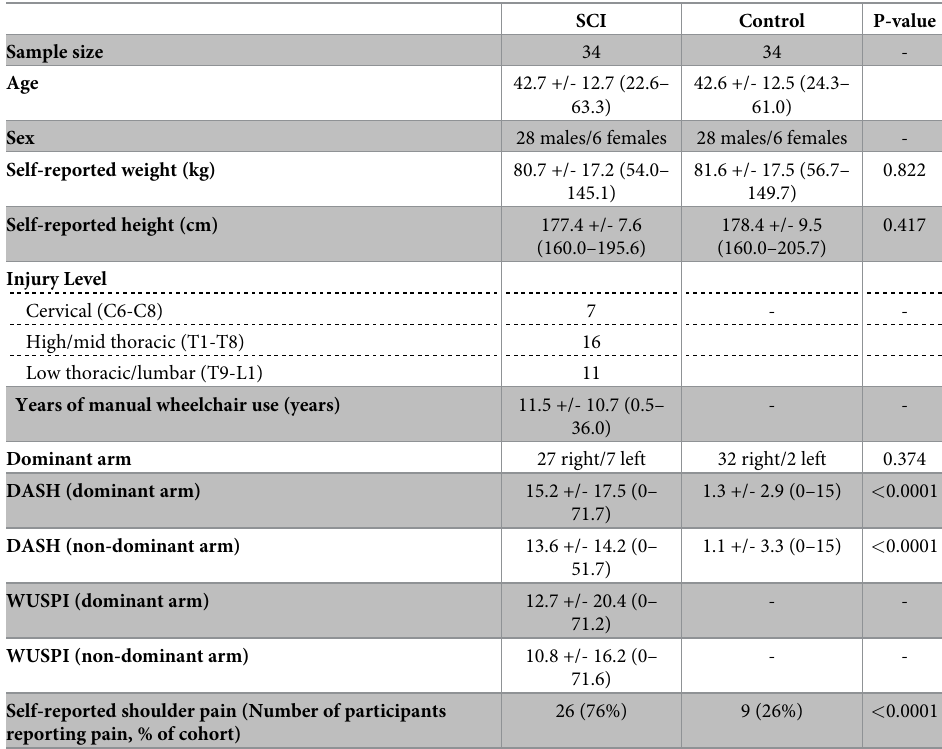
Table 1. Participant